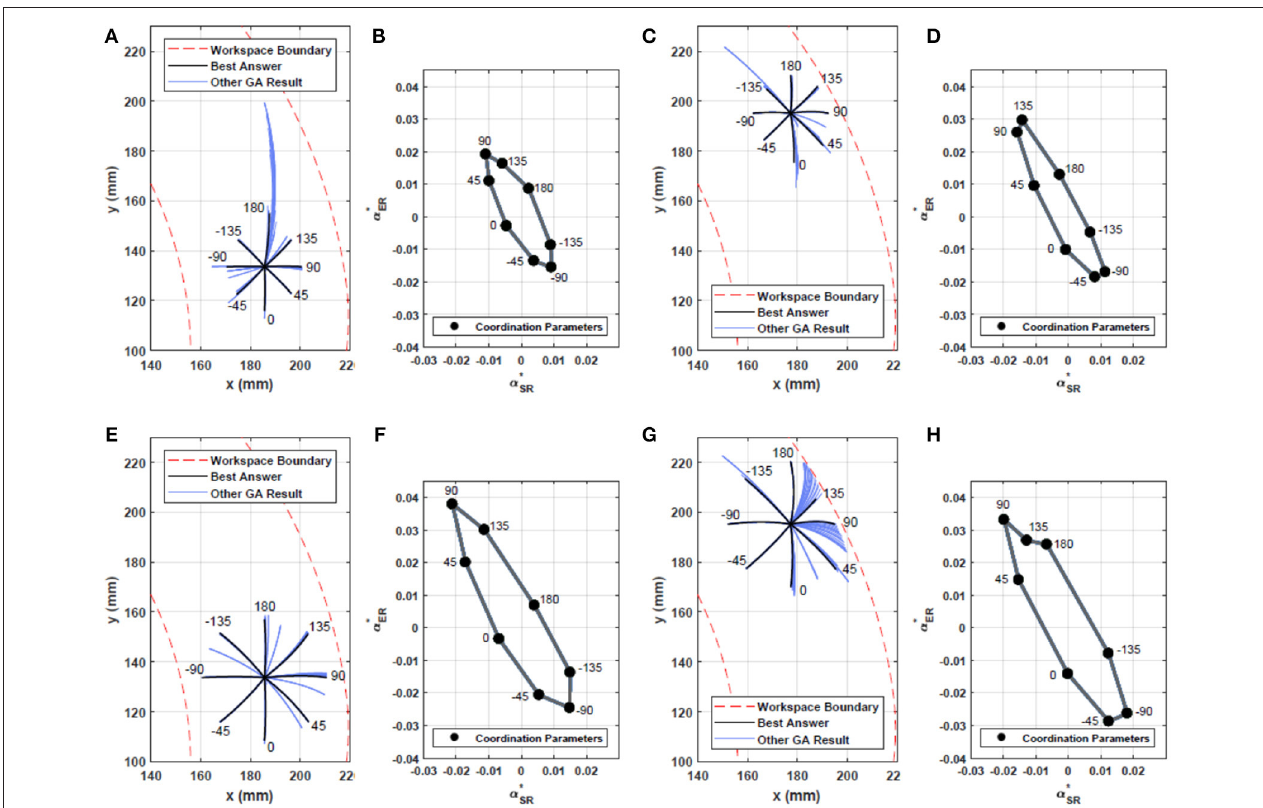
FIGURE 2 | Motor coordination to draw lines with eight desired angles (0,45,90,135,180, − 135, − 90, − 45) using a multi-objective Genetic Algorithm. (A–C) show the resulting drawing from the optimization at two different arm initial positions with a line length of 15 mm . (B,D) show the coordination parameters of the black lines in (A,C) that resulted from the optimization process. Each point represents parameters ( α and i inj ) of a spatio-temporal coordination for a drawn line. The horizontal axis represents the coordination parameters for the Shoulder Roll (SR), the vertical axis for the Elbow Roll (ER). (E–H) represent the resulting optimization for a line length of 25 mm . Although there exists no linear mapping from a point on Cartesian workspace and its coordination parameters to a different point (and its coordination parameters), (A–D) , there is however a linear relation between coordination parameters of lines drawn from one point with similar angle but with different lengths, (B,F,D,H) . In (G) , due to the starting position being close to the boundary of the workspace, it can be seen that for the line with angle 135 ◦ and length of 25 mm our method settled for the coordination parameters with a length smaller than the desired, hence (H) not being the scaled version of (D) .